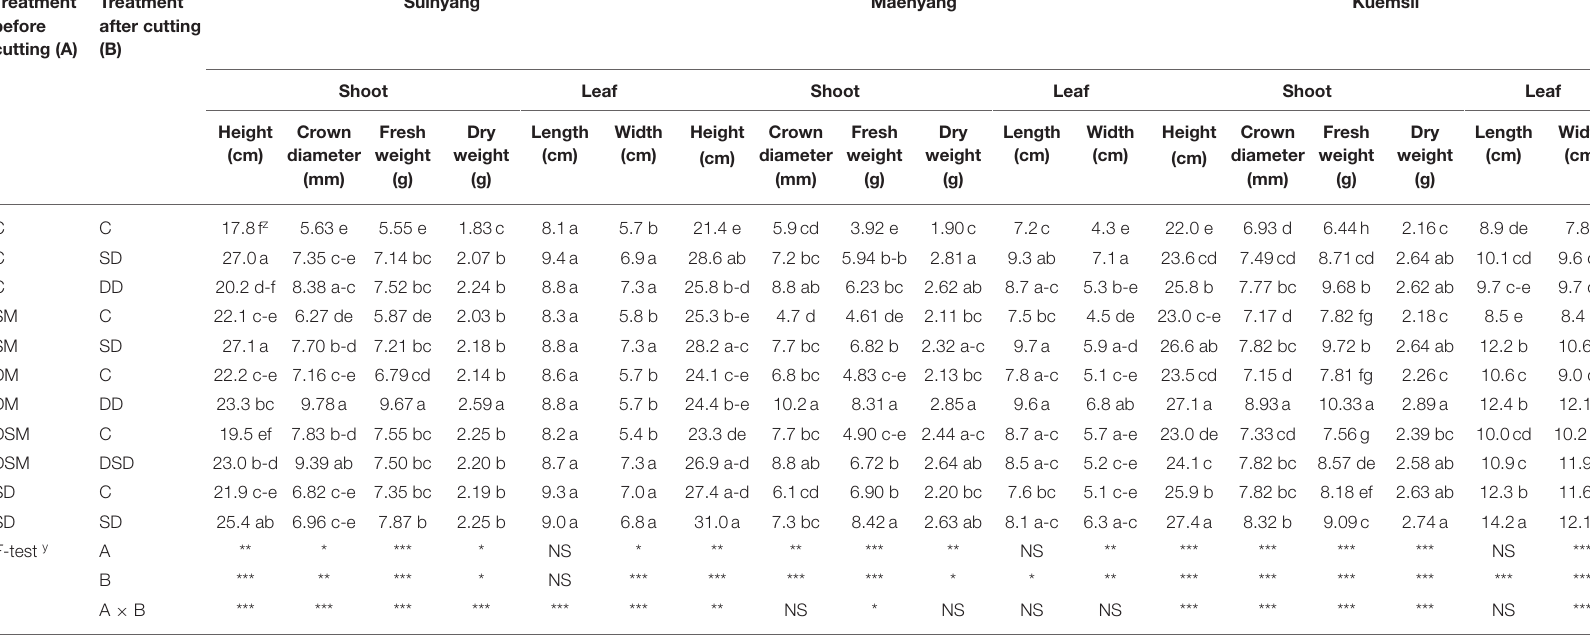
TABLE 2 | The growth parameters as affected by the Si treatment in strawberry transplants after subjection to 43 ◦ C for 7 days. Treatment before cutting